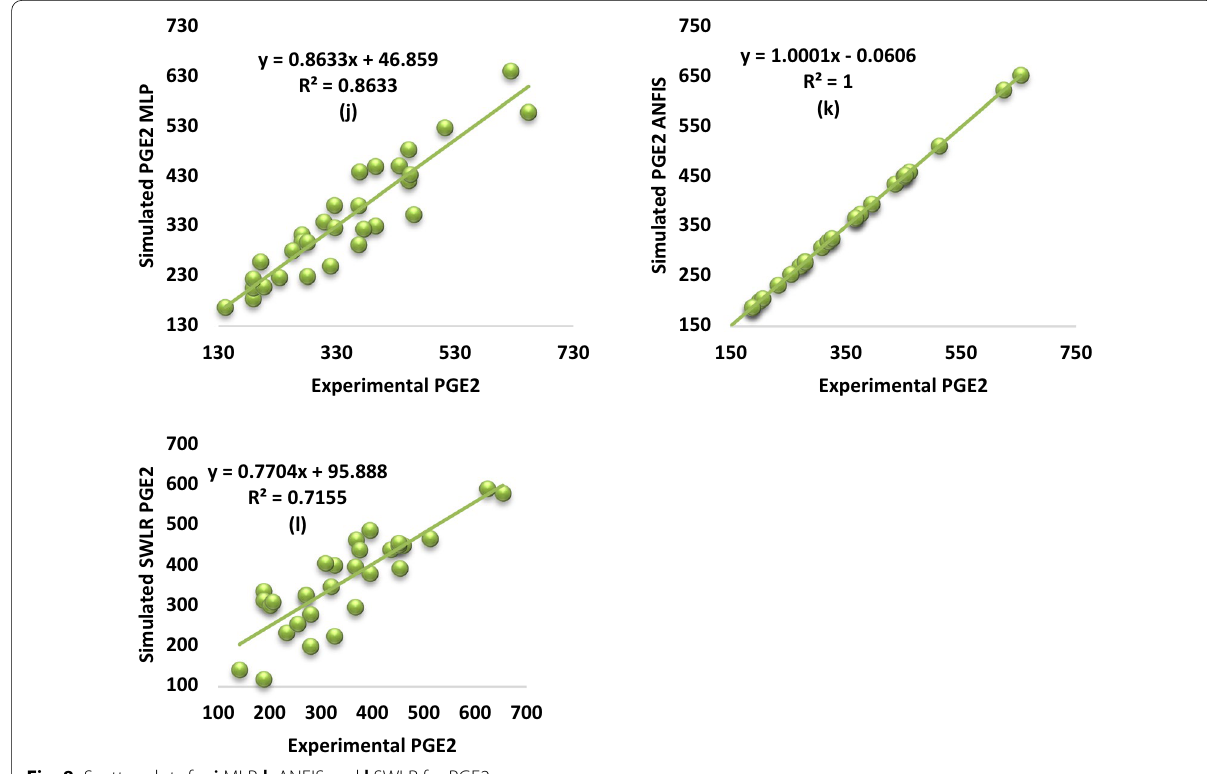
Fig. 8 Scatter plots for j MLP, k ANFIS and l SWLR for PGE2